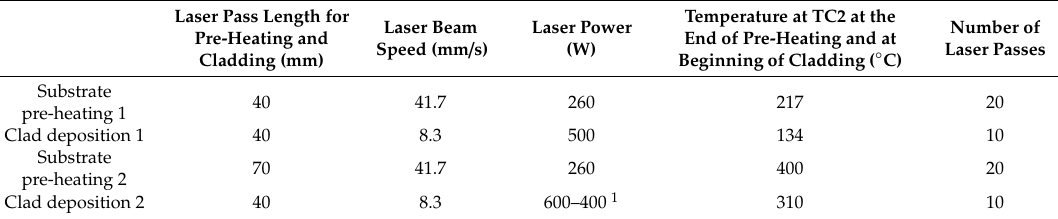
Table 2. Process parameters and TC2 thermocouple values.